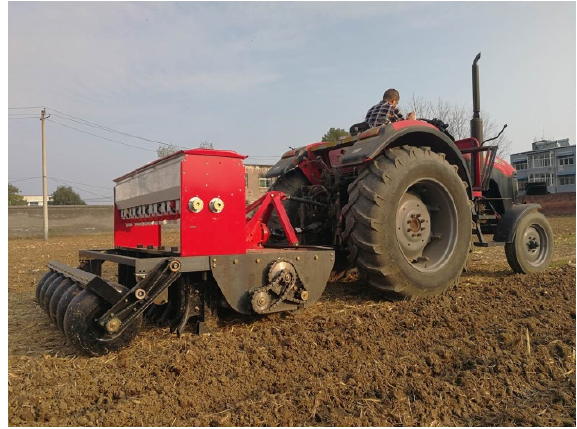
Figure 11. Field verification test.